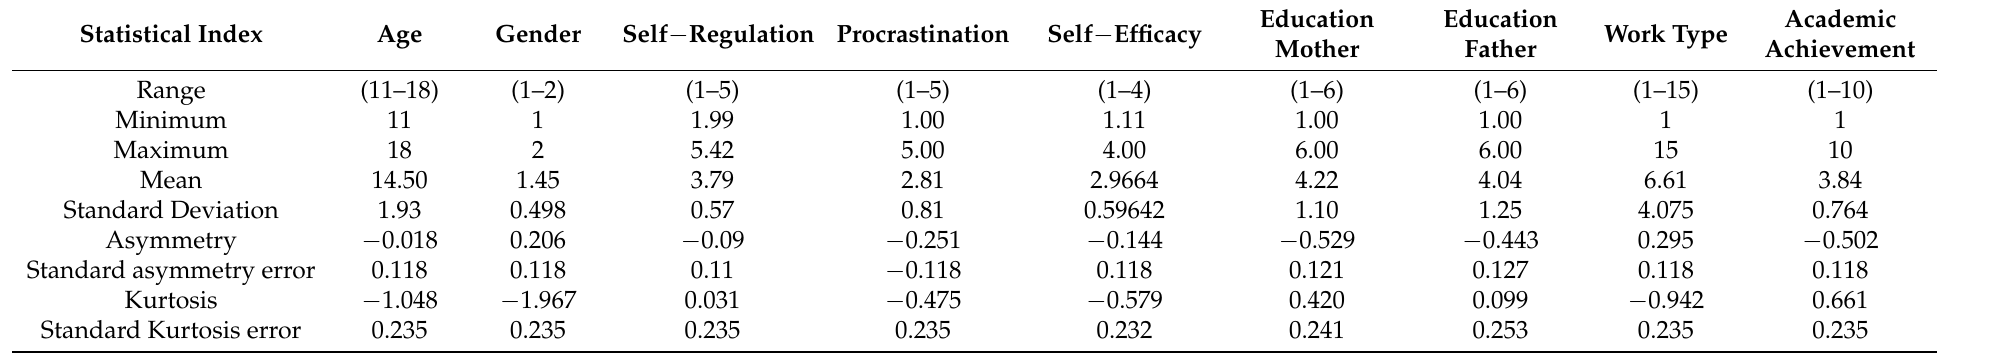
Table 1. Descriptive and normative values of the sample ( n =